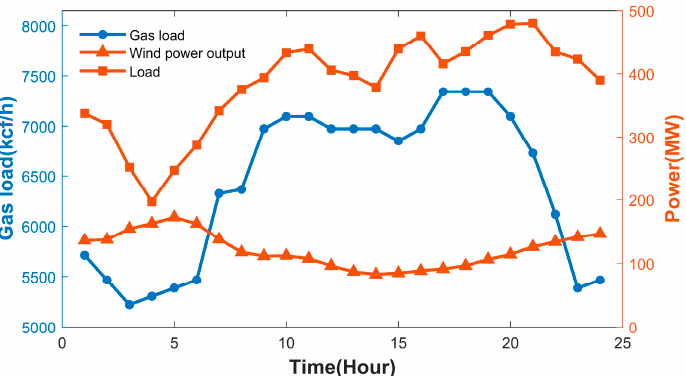
Figure 2. Forecasted wind power generation, power load, and natural gas load curve. The 6-bus power grid consisted of 5 generating units and 7 transmission lines. Units G1, G2, and G3 represented traditional coal-fired thermal power units. The cost coefficient of the coal-fired units was 2.5 USD/MBtu. Units G4 and G5 represented the gas-fired units connected to nodes 3 and 1 of the natural gas network and bus 6 and bus 3 of the power system, respectively. The power load was at bus 2, bus 3, and bus 6 in the power grid. A wind farm with an ESS was connected to bus 4 of the power grid. The gas wells W2 and W1 were connected to nodes 6 and 7 of the natural gas network and the cost coefficients